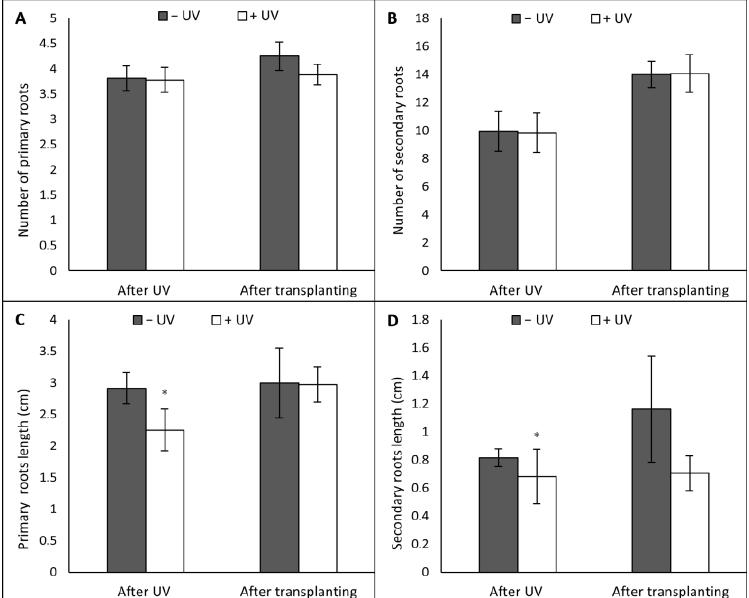
Figure 10. Parameters measured were the number of primary roots ( A ), the number of secondary roots ( B ), primary roots length (cm) ( C ) and secondary roots length (cm) ( D ). Before the UV exposure stage, the mean number of primary roots was 3.8, the mean of the number of secondary roots was 6.85 while the mean length of the primary roots was 2.47 cm, and the mean length of the secondary roots was 0.80 cm. Asterisks indicate a significant difference between the UV treatments with p < 0.05 (*).